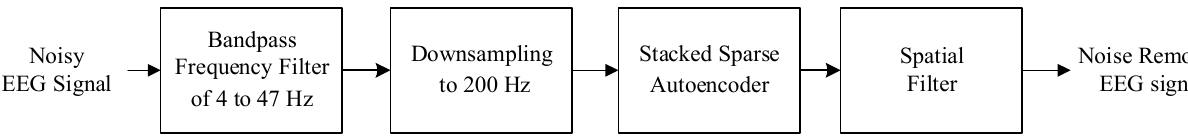
Figure 2. Preprocessing for noise and artifact removal from EEG.